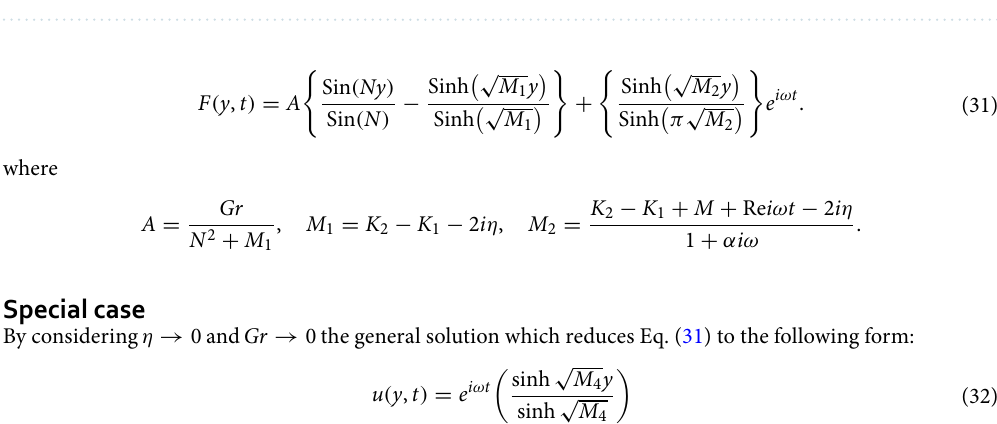
Figure 6. Evolution of F with various values of η if t = 1 ; Gr = 2.5 ; K 1 = 0.5 ; N = 1 ; M = 0.2 ; (cid:31) = 0.5 ; Re = 1 ; α = 0.1 ; ω = 0.5 ; ε = 0.001